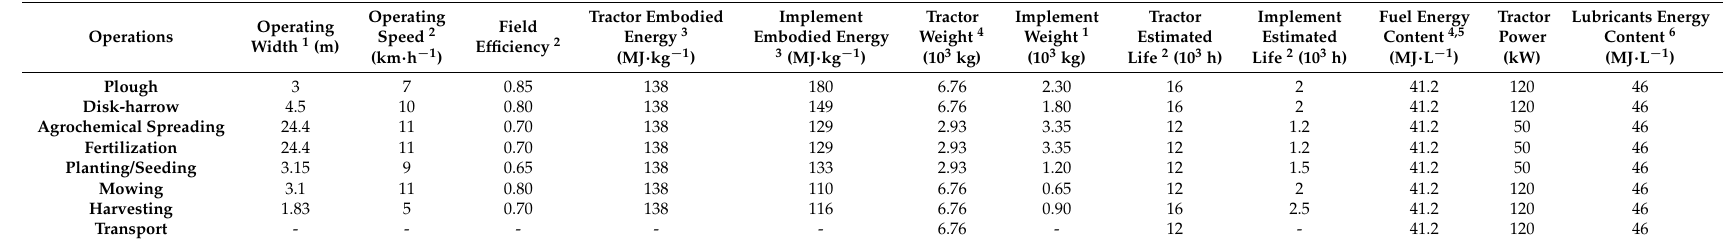
Table 2. Field Machinery Inputs.